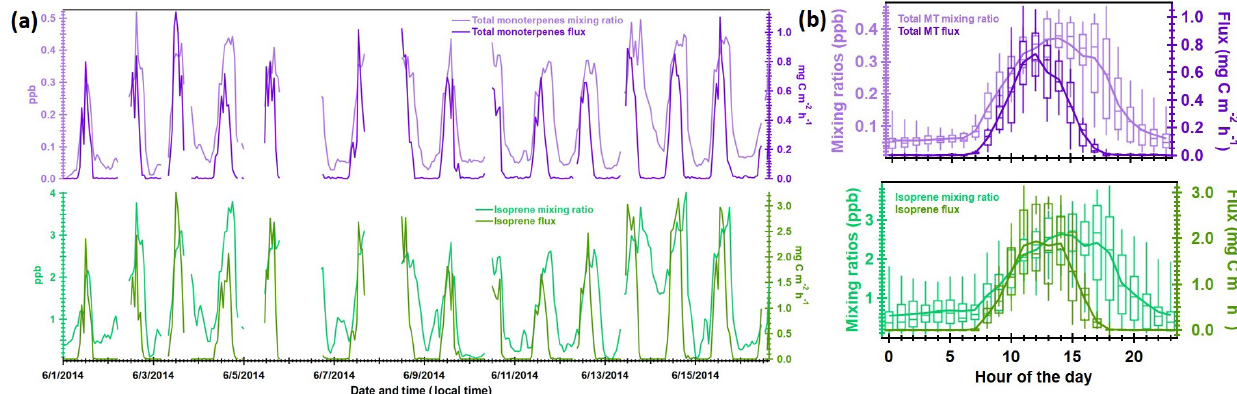
Figure 3. (a) Time series profile for the measured isoprene and total monoterpene mixing ratios and fluxes; (b) box-and-whisker plots for measured mixing ratios and fluxes of isoprene and total monoterpenes